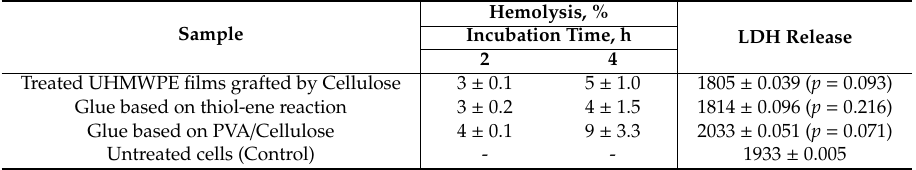
Table 7. The hemocompatibility test results ( ± standard deviation).